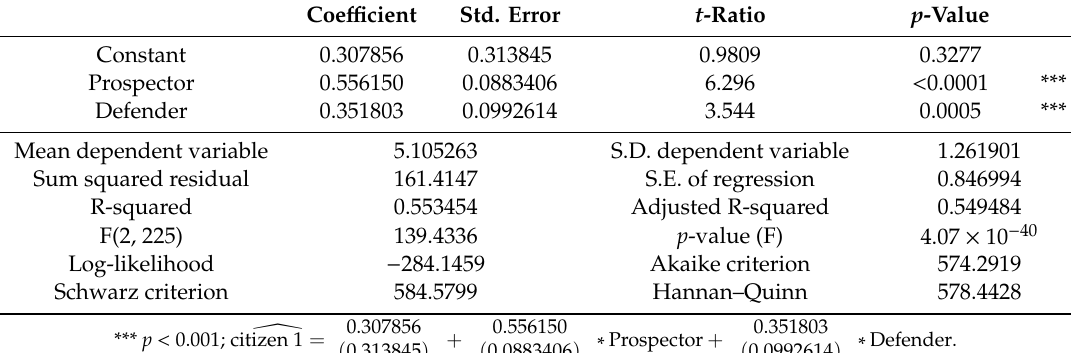
Table 1. Model 1: Ordinary Least Squares (OLS), using observations 1–228. Dependent variable: Citizen 1.